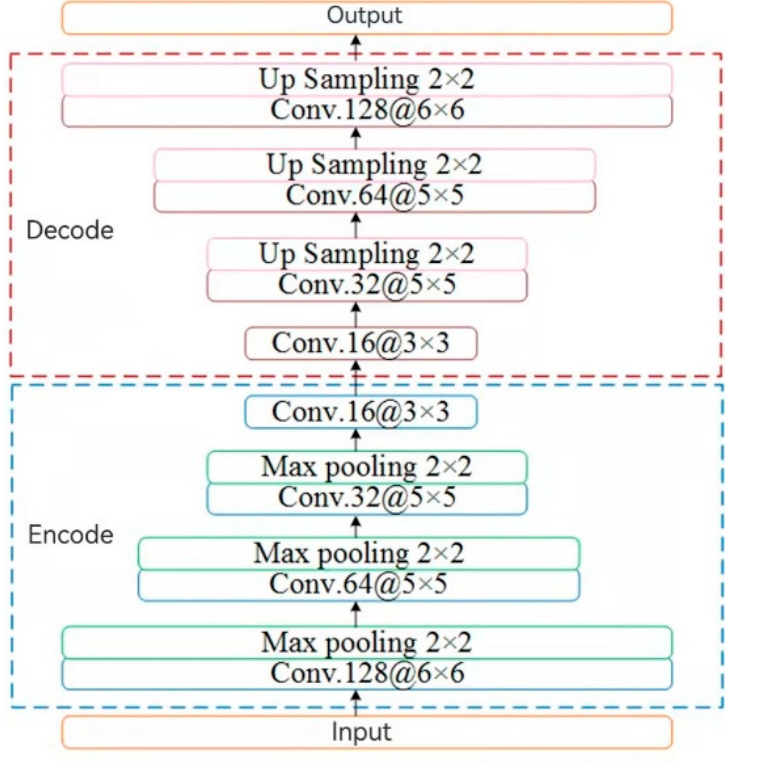
Figure 4. Dataset augmentation operation.